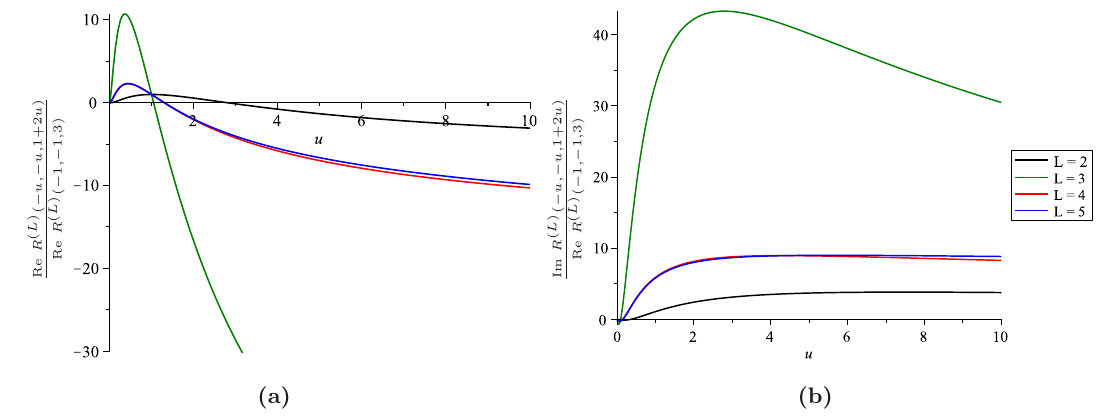
Figure 4. Real (a) and imaginary (b) part of the L -loop form factor remainder function R ( L ) on the line ( u, u, 1 − 2 u ) in scattering region IIIa, u < 0 , normalized by the value of its real part at u = − 1 .